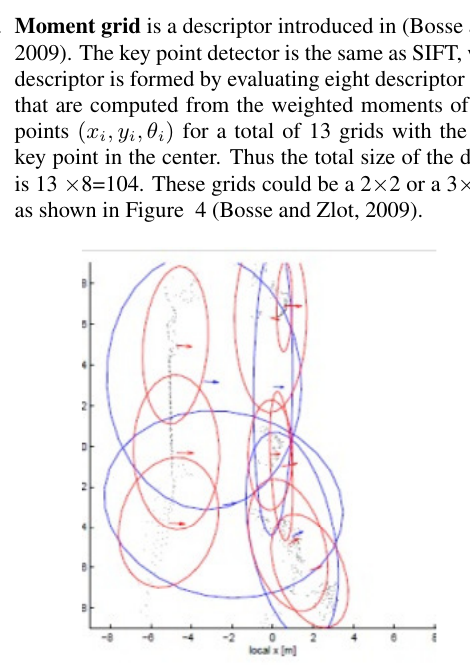
Figure 4: Moment grid